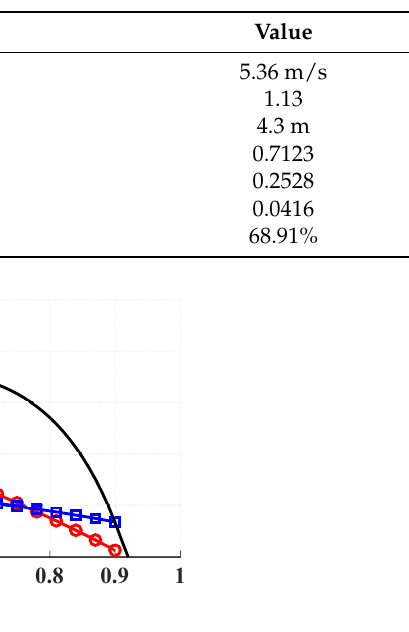
Figure 4. Propeller efficiency, thrust, and torque coefficients as a function of advanced ratio.